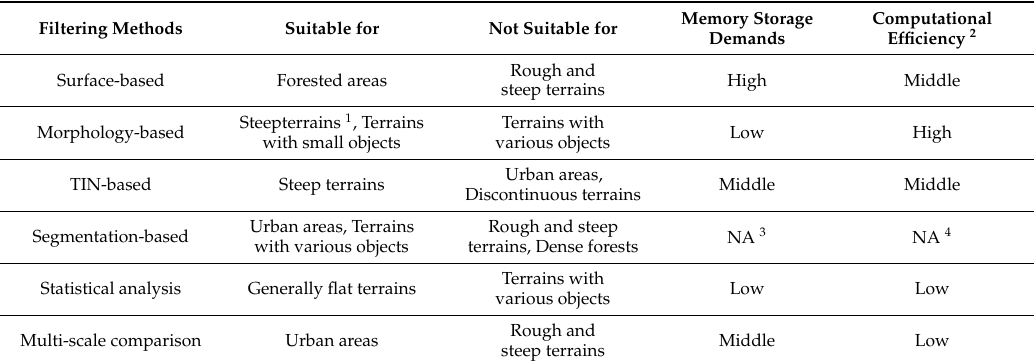
Table 1. Characteristics of different ground point